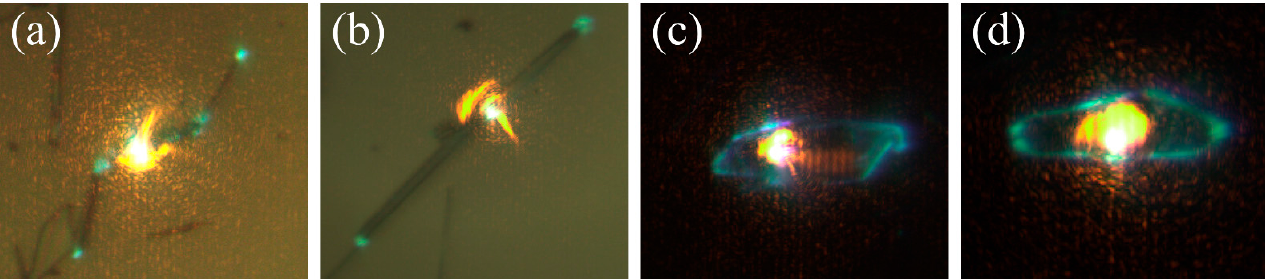
Figure 9. ( a ) CL spectra of elongated structures of L-M-H samples. ( b ) CL spectrum on a structure of triangles.